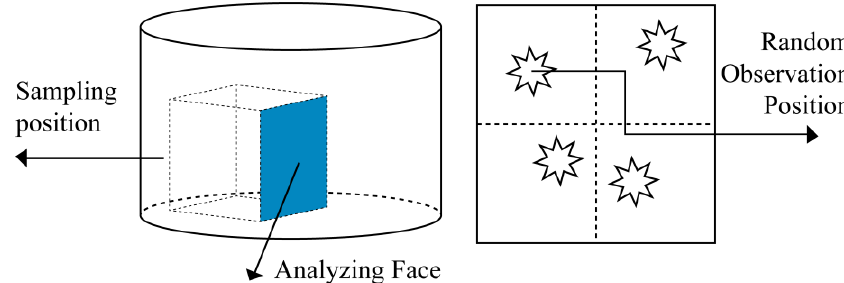
Figure 3. Sampling place, analyzing face, and random observation position.